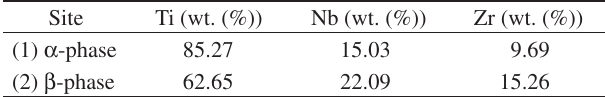
Table 2. Ti, Nb e Zr contents in the areas analyzed (EDS).